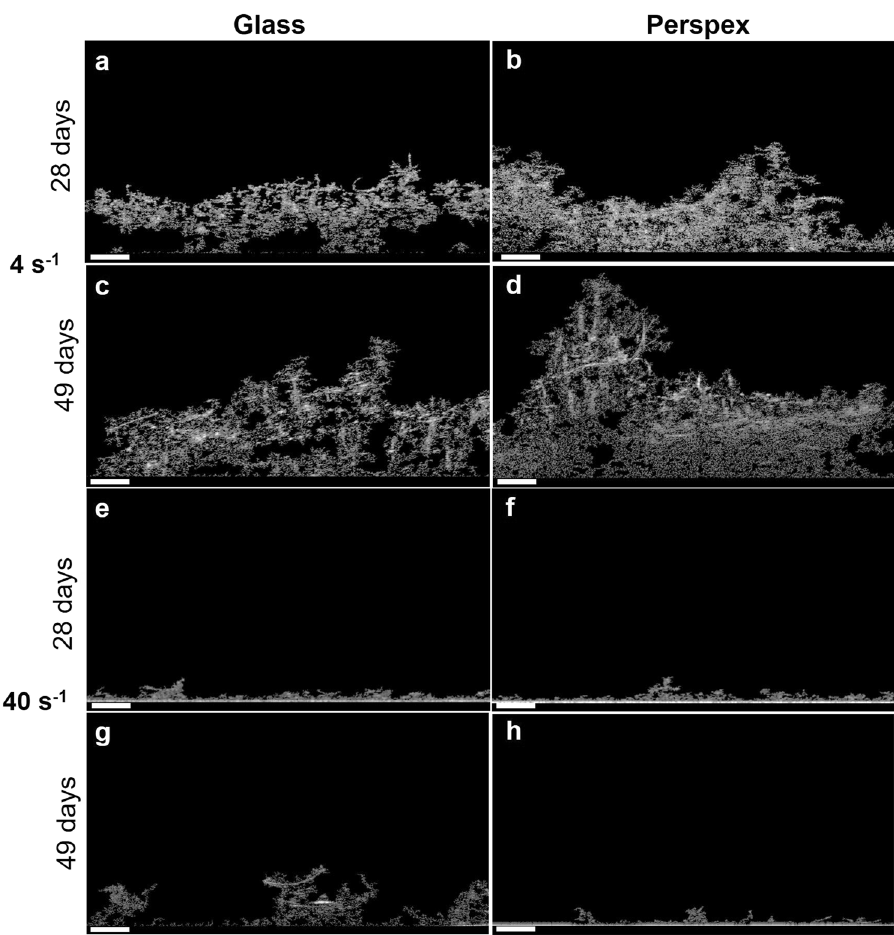
Fig. 3 2D cross-sectional OCT images of Toxi fi lum sp. LEGE 06021 bio fi lms. The representative images show bio fi lms formed on glass and perspex at two different shear rates, 4 s − 1 ( a – d ) and 40 s − 1 ( e , f ), and the bio fi lm structure evolution from days 28 to 49. Scale bar = 200 μ